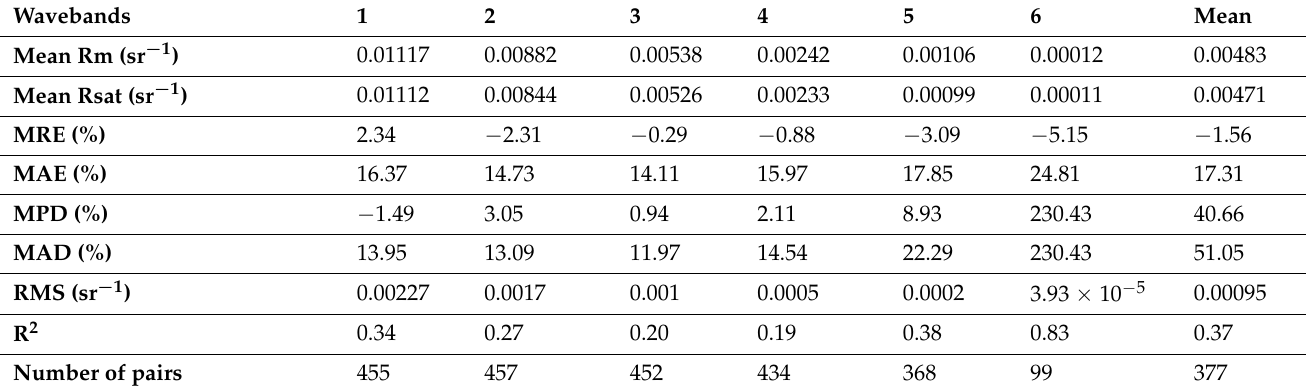
Table 2. Comparison of the R rs between the COCTS/HY ‐ 1C and MOBY measurements.